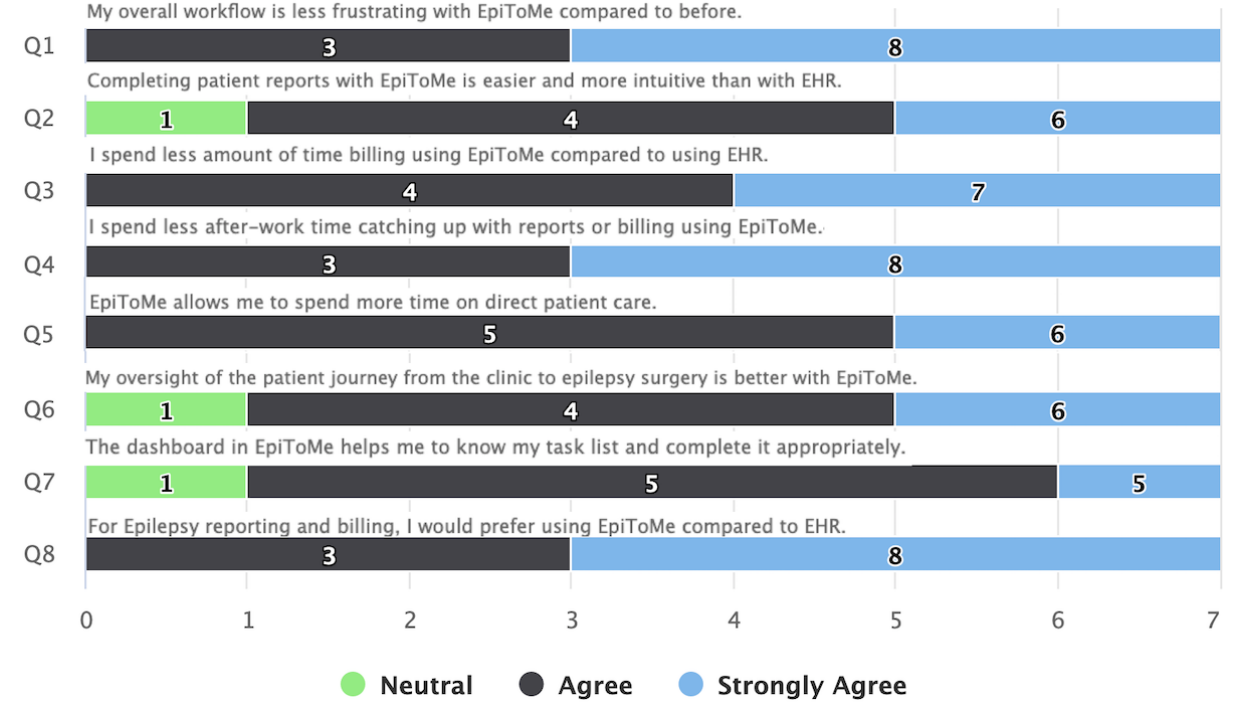
Figure 6. Responses for survey questions 1-8. EHR: electronic health